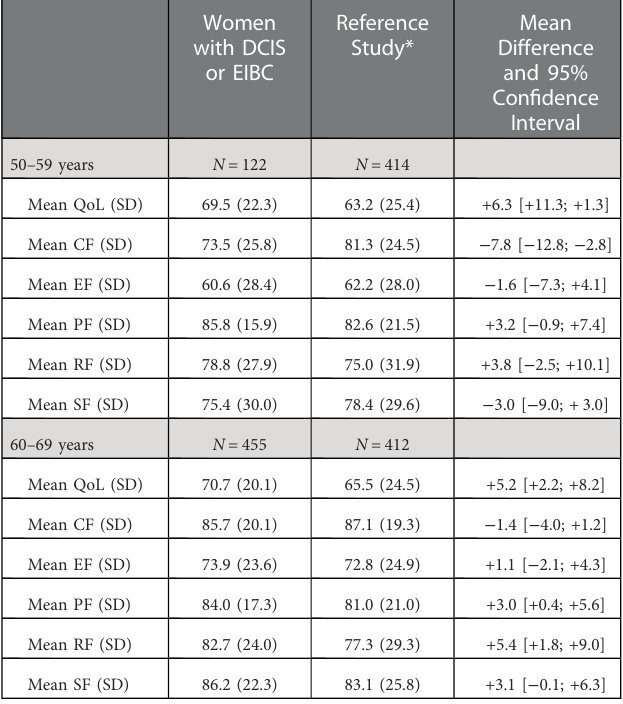
TABLE 2 Mean values (and standard deviation, SD) of scores values among women with ductal carcinoma in-situ or early invasive breast cancer and the reference study.